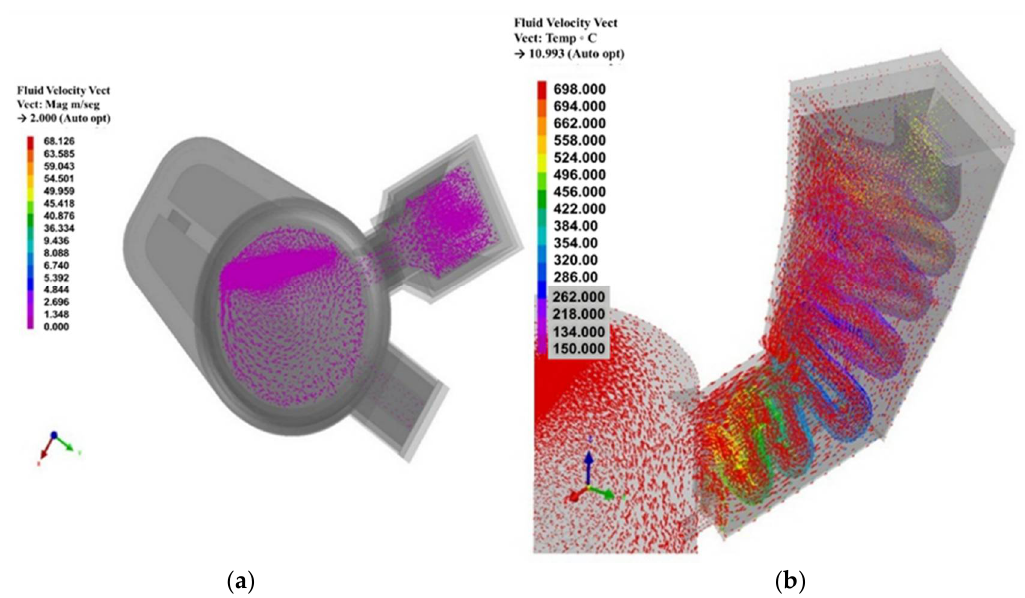
Figure 7. ( a ) Velocity vectors from inside the furnace; ( b ) temperature profiles along the melting tower after 3600 of simulating time.